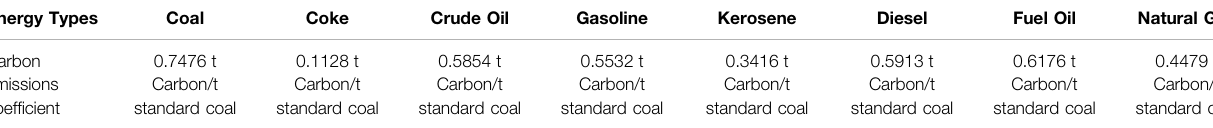
TABLE 1 | Carbon emissions coef fi cient.